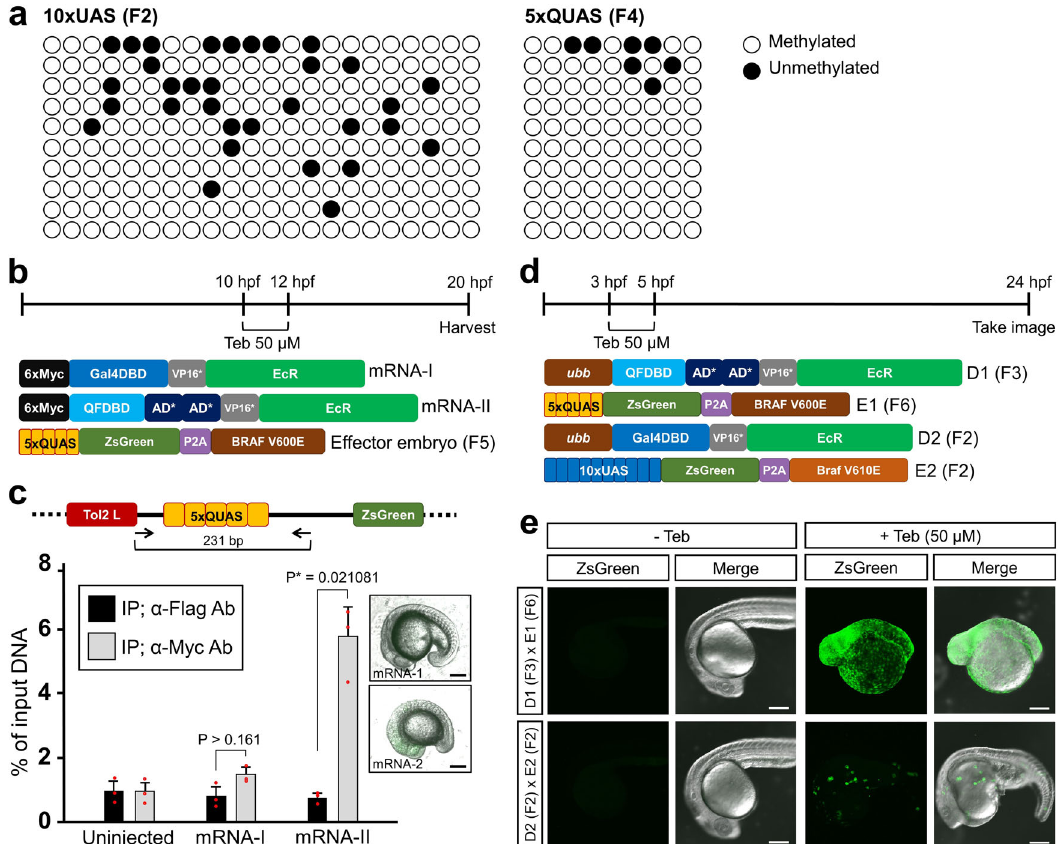
Fig. 2 The activity of IQ-Switch is not in fl uenced by QUAS methylation. a The prepared genomic DNA from F2 offspring of Tg ( 10xUAS : ZsGreen-P2A- braf V610E ) and F4 offspring of Tg ( 5xQUAS : ZsGreen-P2A-BRAF V600E ) was subjected to bisul fi te sequencing analysis. Both element regions became heavily methylated through successive generations. Open circles indicated methylated CpGs and dark circles represented unmethylated CpGs. Ten individual clones from each group were independently sequenced as shown on the vertical axis. b Schematic diagram of ChIP experiments in ( c ). The in vitro transcribed mRNA (50 pg) encoding 6x Myc -tagged Gal4DBD-VP16*-EcR and 6xMyc-QFDBD-2xAD*-VP16*-EcR was introduced into the embryos of Tg ( 5xQUAS : ZsGreen-P2A-BRAF V600E ). The injected embryos were exposed to 50 µ M of Teb for 2 h at the early somite stage and then harvested at 20 hpf. c An amplicon encompassing the 5xQUAS element region occupies 231 bp. ChIP assay of embryo with anti-Myc and anti-Flag antibody. The anti-Flag antibody was used as a negative control. The ChIP samples were subjected to qPCR with the indicated primers (arrows). While mRNA encoding 6xMyc - Gal4DBD-VP16*-EcR did not cause any embryonic malformation when exposed to Teb, sporadic exposure of 6xMyc-QFDBD-2xAD*-VP16*-EcR mRNA- injected embryos to Teb showed developmental defects (boxes). q-PCR was carried out in triplicate, and standard errors of the mean are shown in the panel. Error bars stand for the standard deviation. d The embryos were treated with 50 µ M of Teb for 2 h before the onset of gastrulation and then observed at 24 hpf. e While ZsGreen reporter under the control of QF/5xQUAS showed ubiquitous expression in the whole embryo (D1 + E1), the same reporter was activated in random tissues when driven by Gal4/10xUAS (D2 + E2). Note that 10xUAS regulated by Gal4 was progressively silenced as